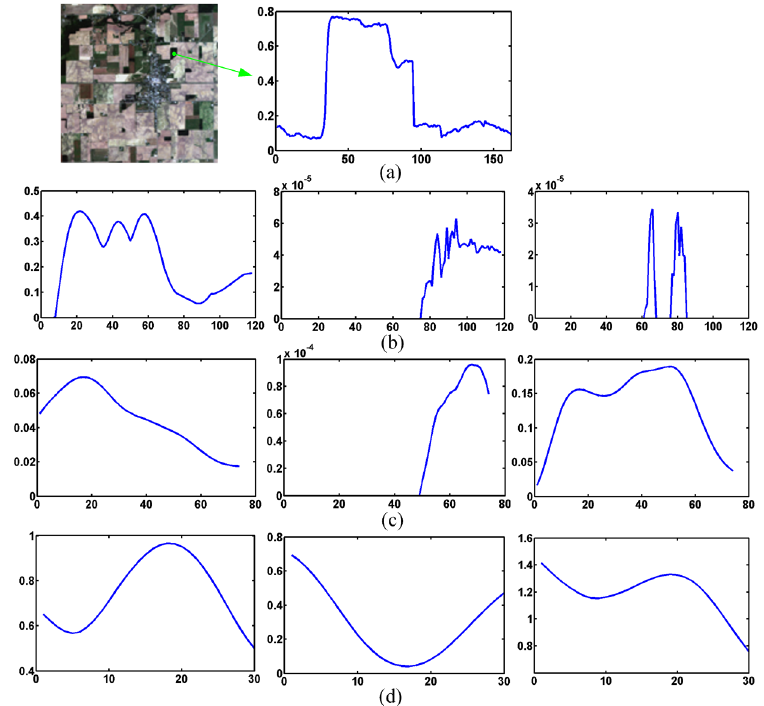
Figure 19. The extracted features of different convolutional layers in HSI branch, the features are extracted from a spectrum with coordinate (76,185) of AVIRIS Indian pines data, ( a ) input spectrum of LR HIS; ( b ) features of the first layer; ( c ) features of the second layer; ( d ) features of the third layer.